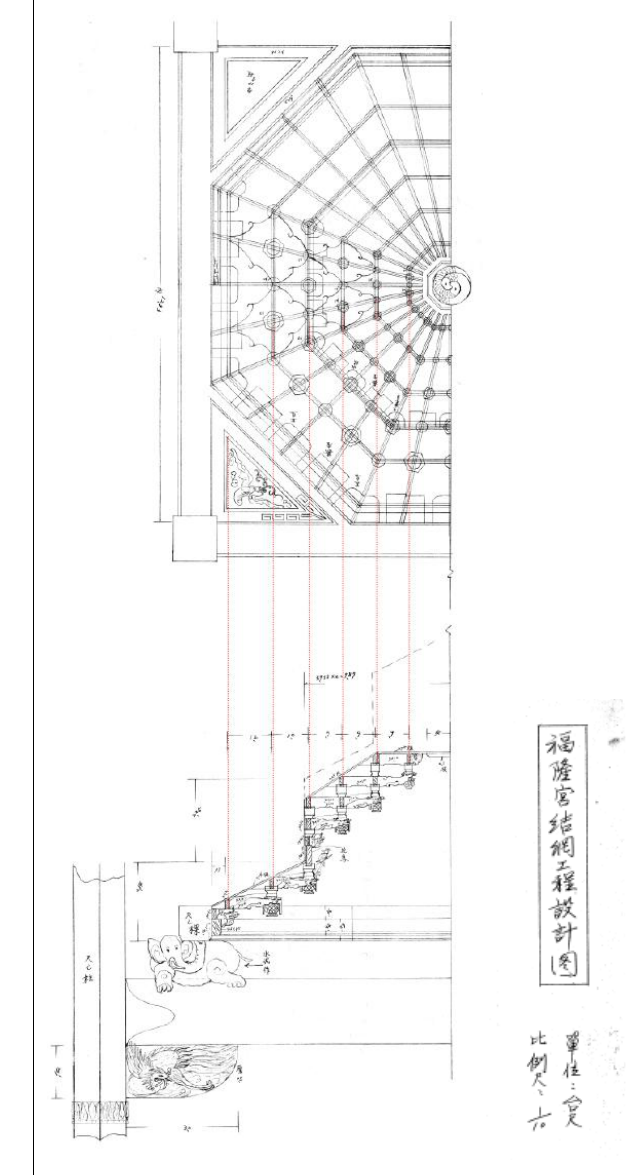
Figure 5. Lukang Tin Hau Temple Caisson